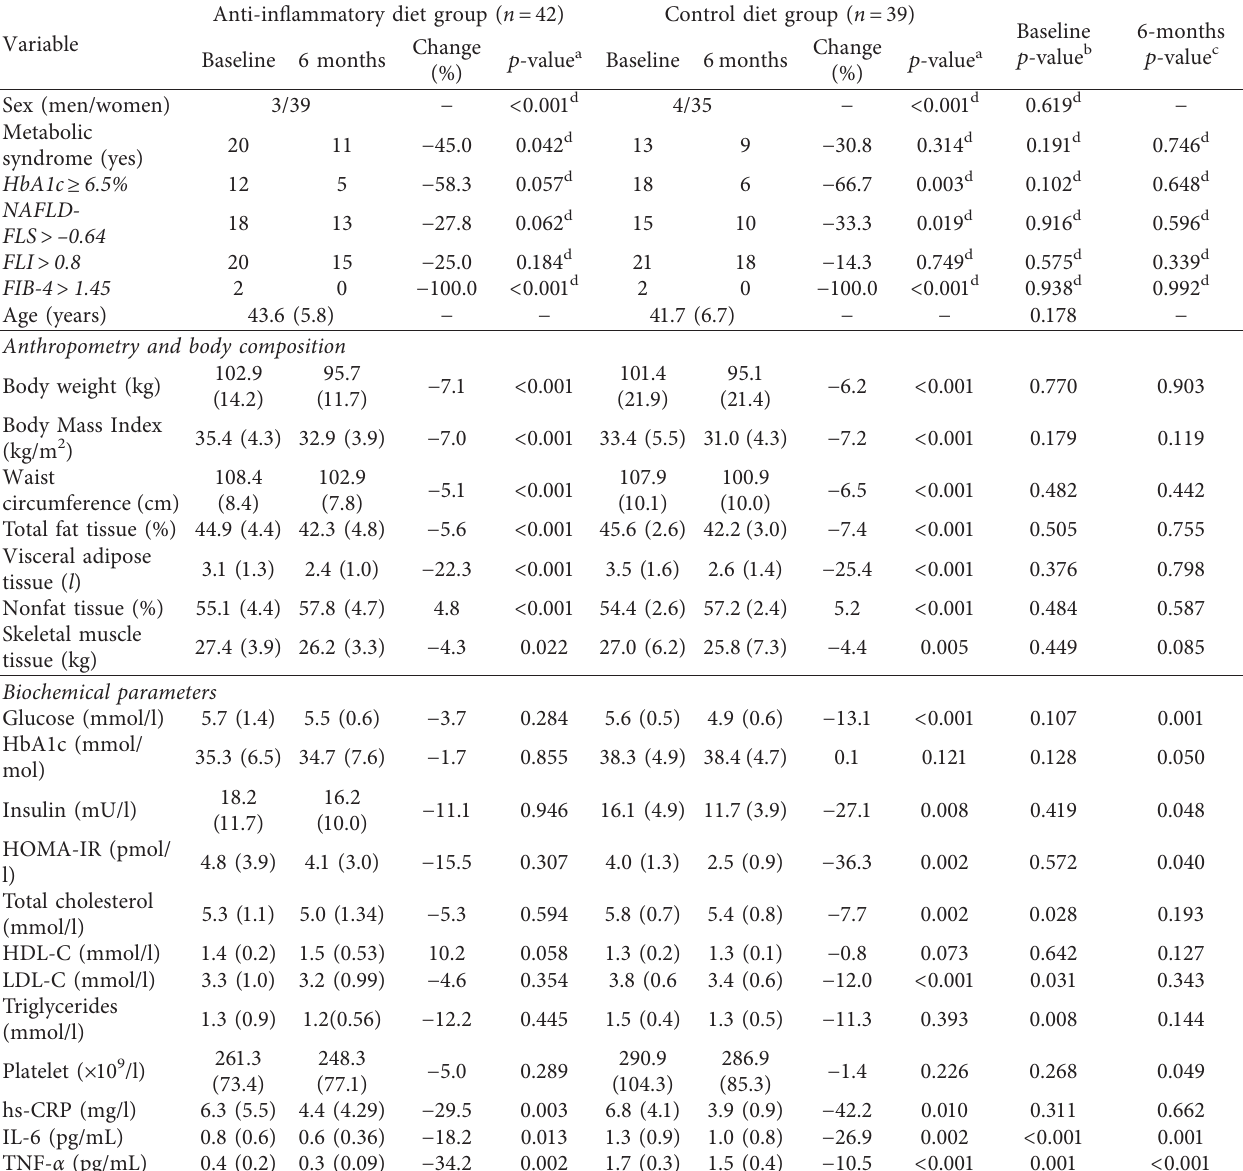
Table 1: Patient characteristics and changes in anthropometric and biochemical parameters at baseline and after 6 months of dietary intervention.